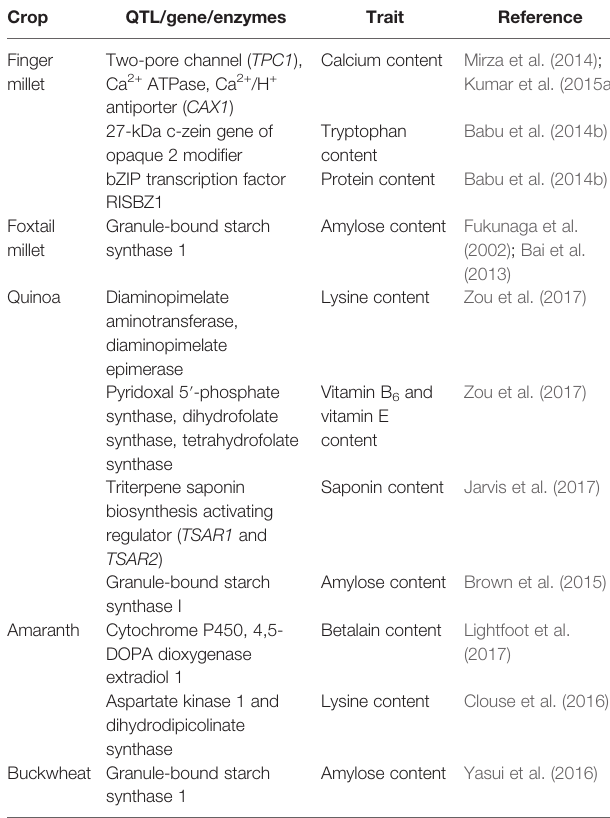
TABLE 7 | Details of genome organization and other characteristics of underused crops. Species Ploidy level Chr. no.